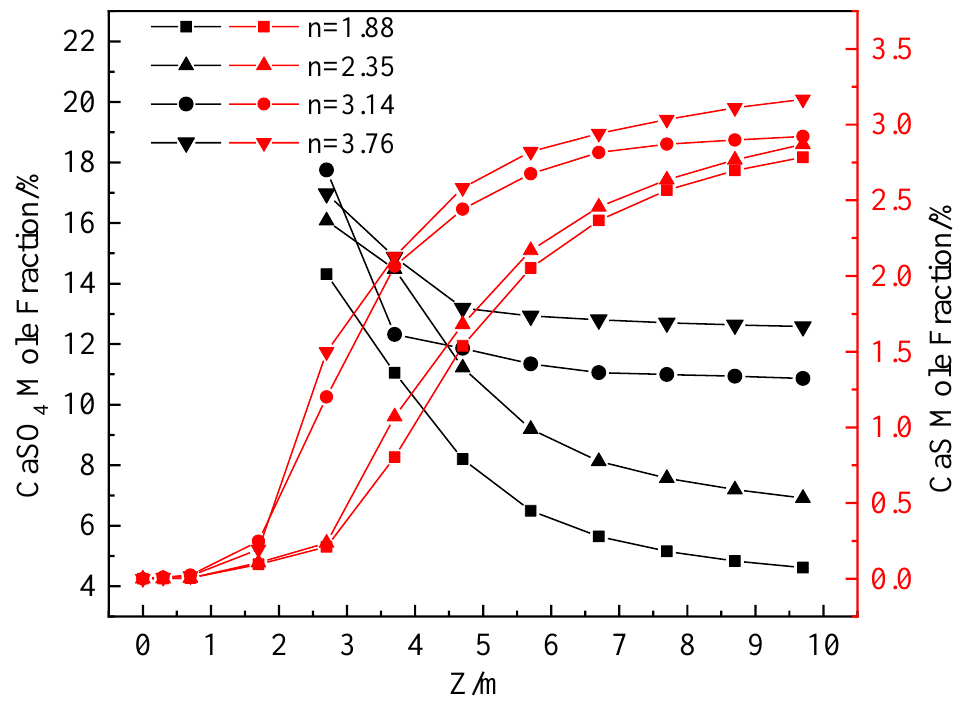
Figure 10. Curve of average mole fraction of solid phase at various sections along the Z-axis of n (CaSO 4 )/ n (S 2 ) conditions.